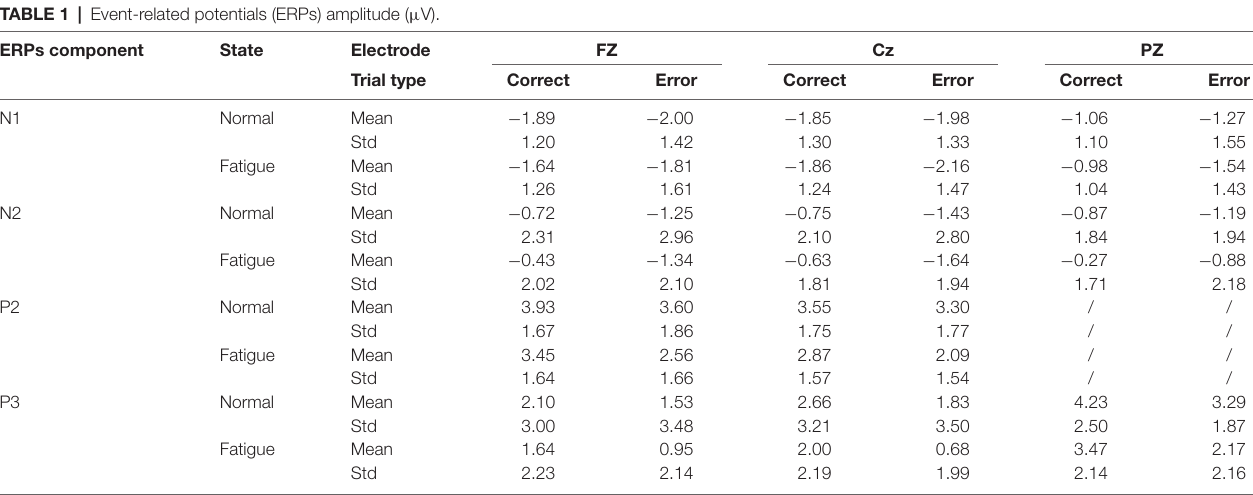
= 0.119. No interaction effects of state p